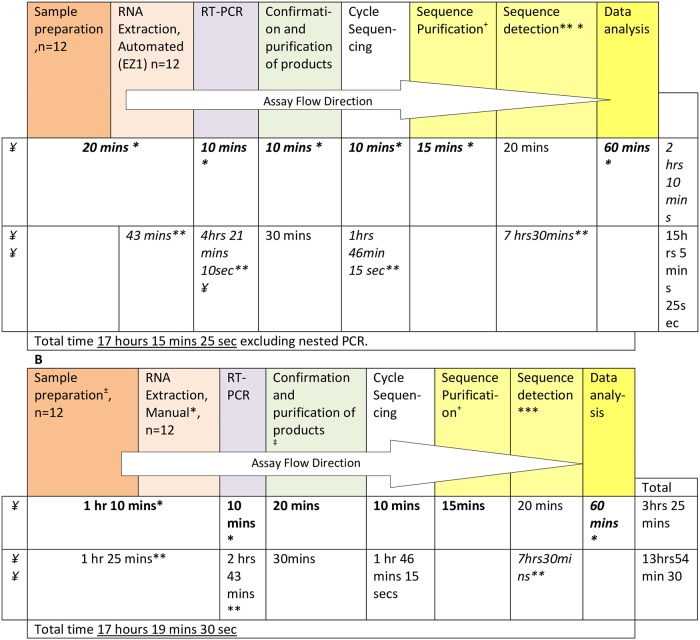
HIV drug resistance testing workflow using an IH-Int and VS-Int assay (panel B).*estimated hands-on time, ** fixed machinery times, #Thermocycler times, + using Zymogen purification kit;*** on 8 capillary ABI PRISM 3130 xl Genetic Analyser for 12 samples, ±ViroSeq HIV-1 Integrase Sample Prep Kit 4J94-72, ‡ purification (Exonuclease 1). RT-PCR, reverse transcriptase-polymerase chain reaction; IH-Int, in-house “home-brew” integrase drug resistance assay; VS-Int, ViroSeq™ HIV-1 Integrase sample preparation and Genotyping kit (Celera Corporation, USA).